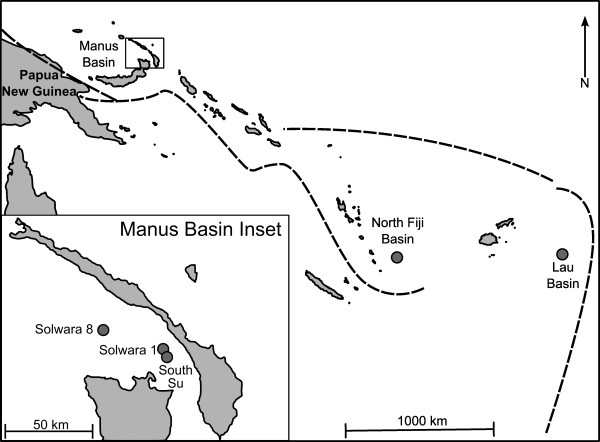
Ifremeria nautilei sampling locations in the western Pacific. Grey circles are approximate location of sampling. Dashed lines represent subduction zones. Three sites sampled in Manus Basin are shown in inset.